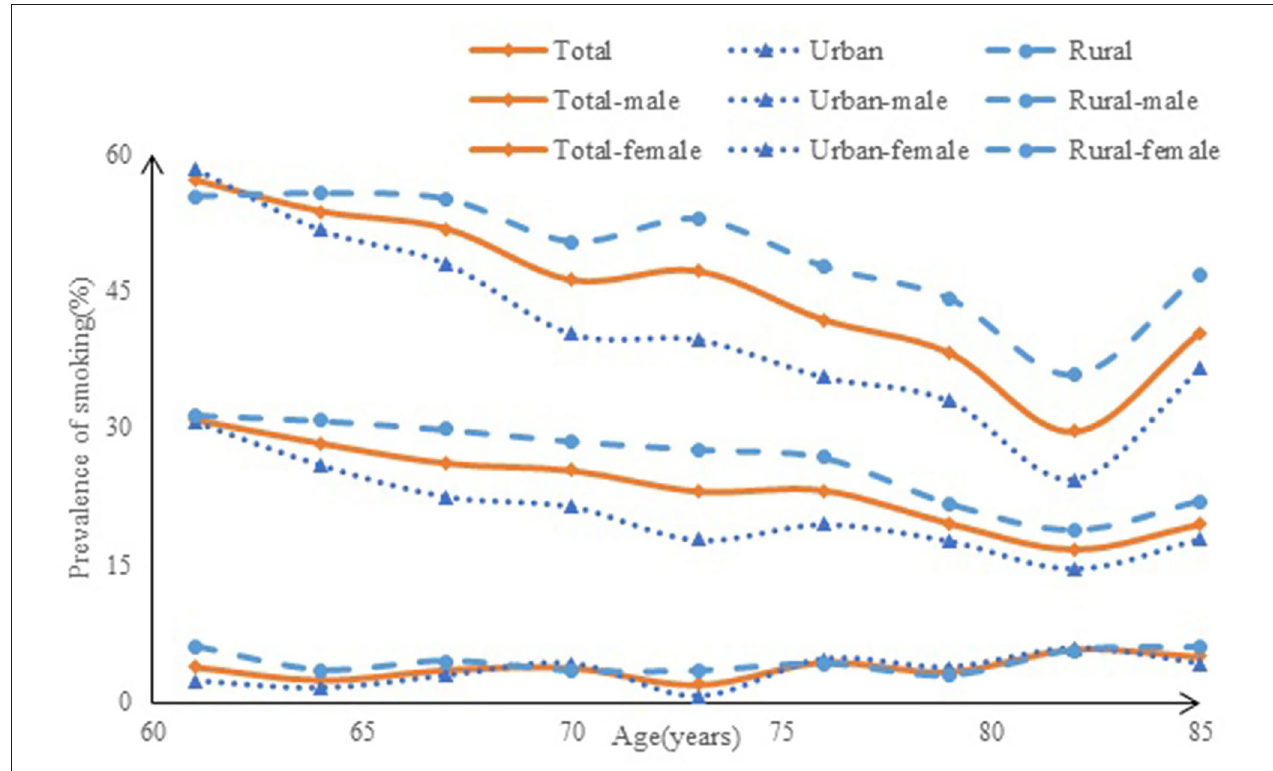
FIGURE 2 | The prevalence of smoking among the elderly in urban and rural areas of China.